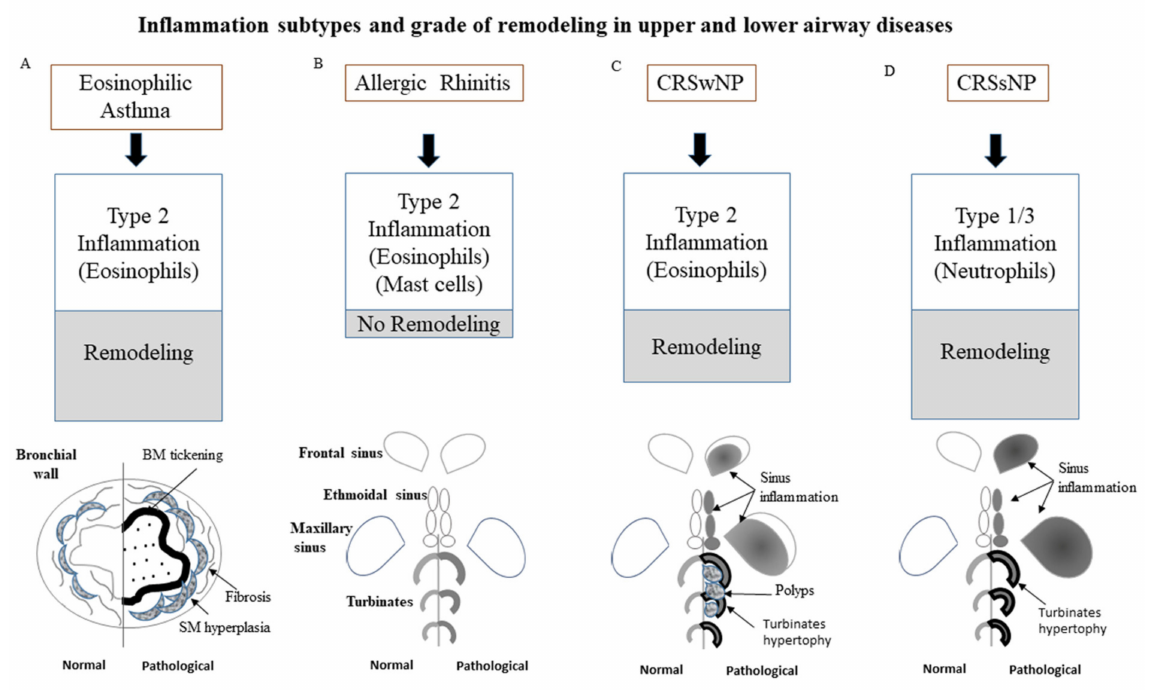
Figure 1. Chronic eosinophilic type 2 inflammatory process at the bronchial wall level of asthmatic patients, both allergic and non, leads to airway remodeling characterized by epithelial damage, goblet cell hyperplasia, subepithelial collagen deposition, airway smooth muscle hyperplasia and increased vascularity ( A ); in allergic rhinitis, despite type 2 inflammation is a disease hallmark, remodeling does not occur ( B ); in CRS type 2 inflammation occurs leading to the development of nasal polyps (CRSwNP), in which the remodeling process is characterized by more evident pseudocyst formation, stromal edema and collagen deposition ( C ); in CRSsNP type 1/3 neutrophilic inflammation is driving force in which remodeling is more evident due to basal membrane thickening, fibrosis and goblet cells hyperplasia ( D